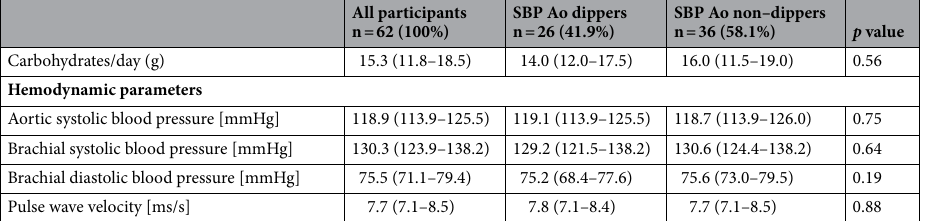
Table 1. Comparison of groups with and without the central non-dipping pattern according to the Arteriograph 24 results. Data presented as median (IQR)/n(%). Bold values denote statistical significance at the p < 0.05 level. ACR albumin to creatinine ratio, ALT alanine transaminase, Ao aortic, AST aspartate transaminase, BMI body mass index, HbA1c glycated hemoglobin, HDL-C high-density lipoprotein, LDL-C